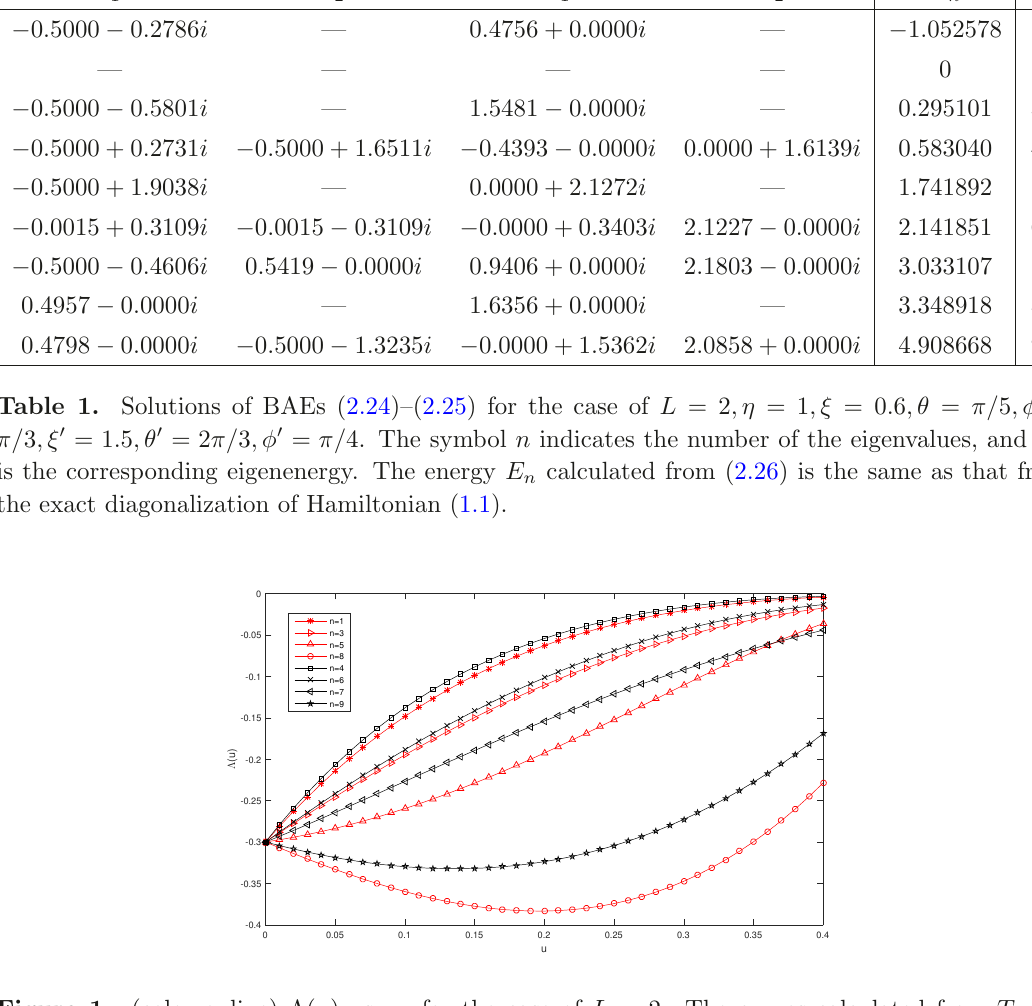
Figure 1. (color online) Λ( u ) vs. u for the case of L = 2. The curves calculated from T − Q relation (2.18) and the nested BAEs (2.24)–(2.25) are exactly the same as those obtained from the exact diagonalization of the transfer matrix t ( u